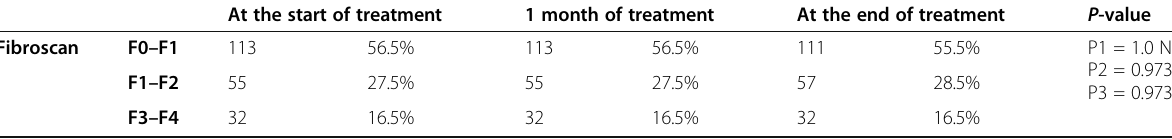
Table 6 Comparison between fibroscan results in the studied patients At the start of treatment 1 month of treatment At the end of treatment P -value